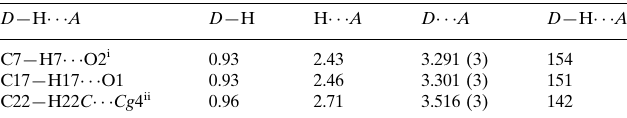
Hydrogen-bond geometry (A˚ , (cid:2)